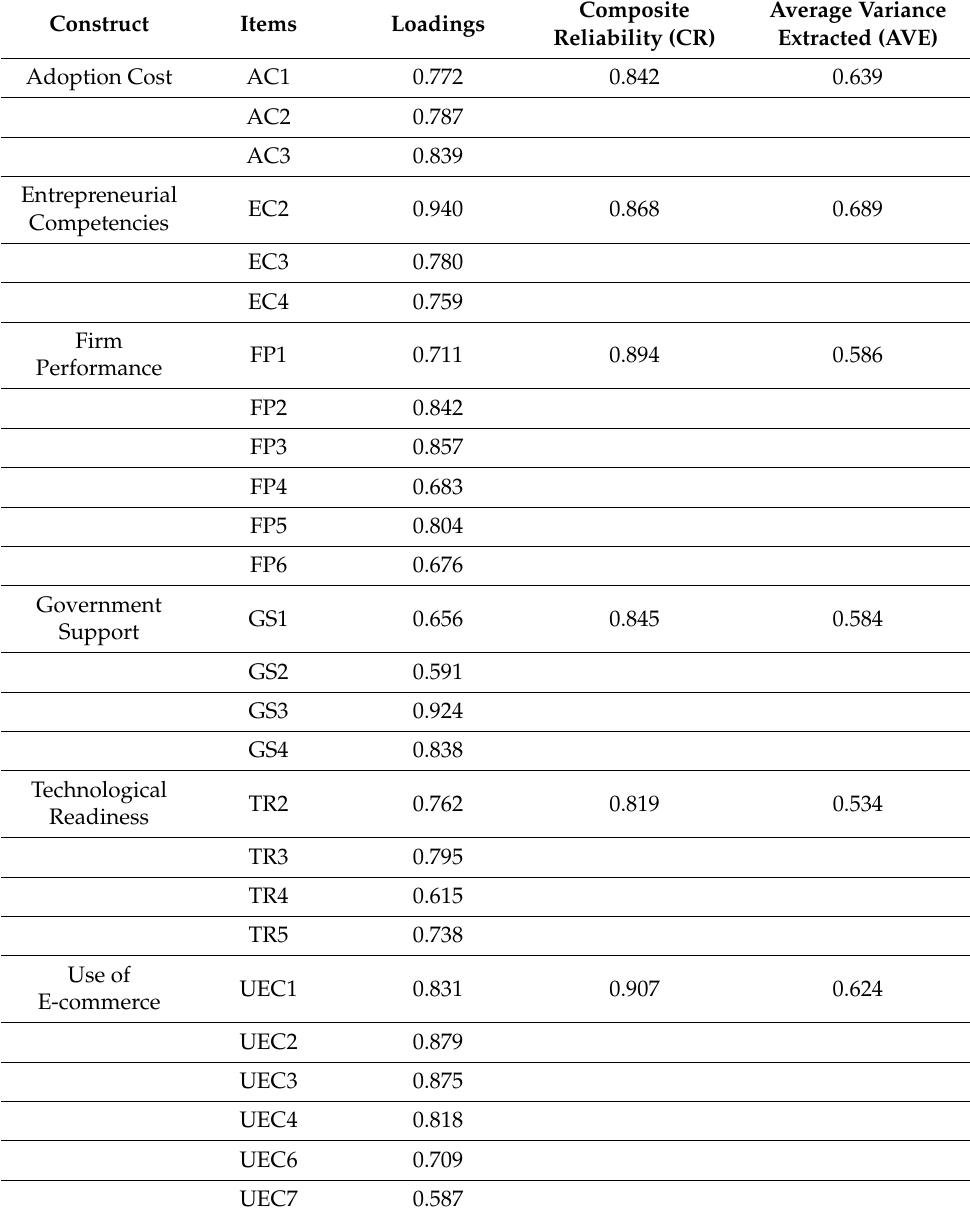
Table 3. Reliability and validity of the